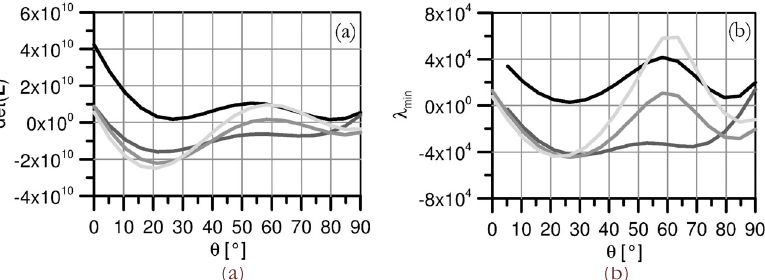
Figure 12: Example 2: plasticity evolution at interface Gauss points and results of localization at four stages indicated in Fig. 11.